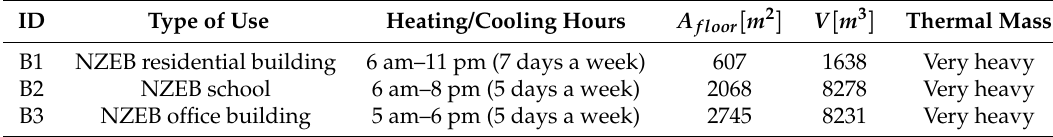
Table 2. Main characteristics of analyzed buildings.